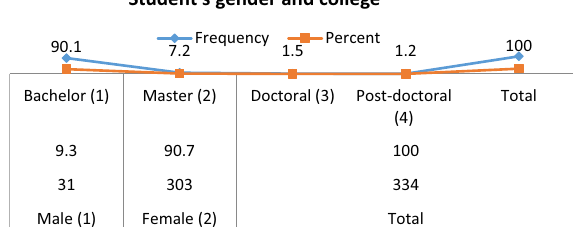
Fig. 1 Student’s gender and college